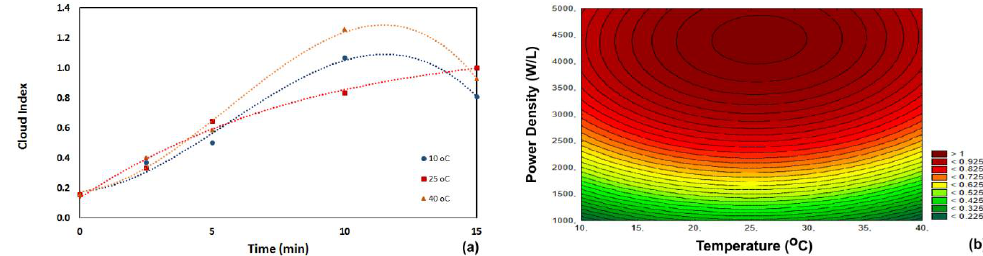
Figure 4. Influence of temperature and processing time on the cloud index of acerola juice. ( a ) Process carried out at 5000 W/L; ( b ) process carried out for 15 min.